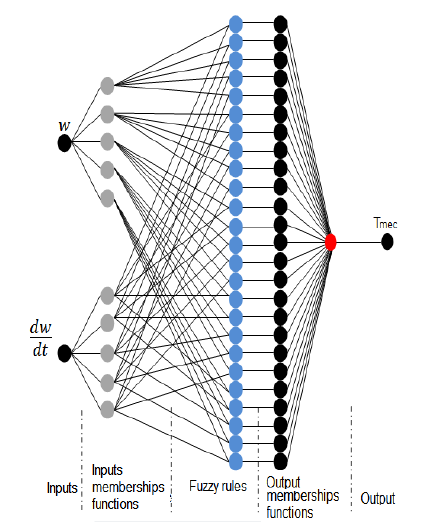
Fig 3. Proposed ANFIS